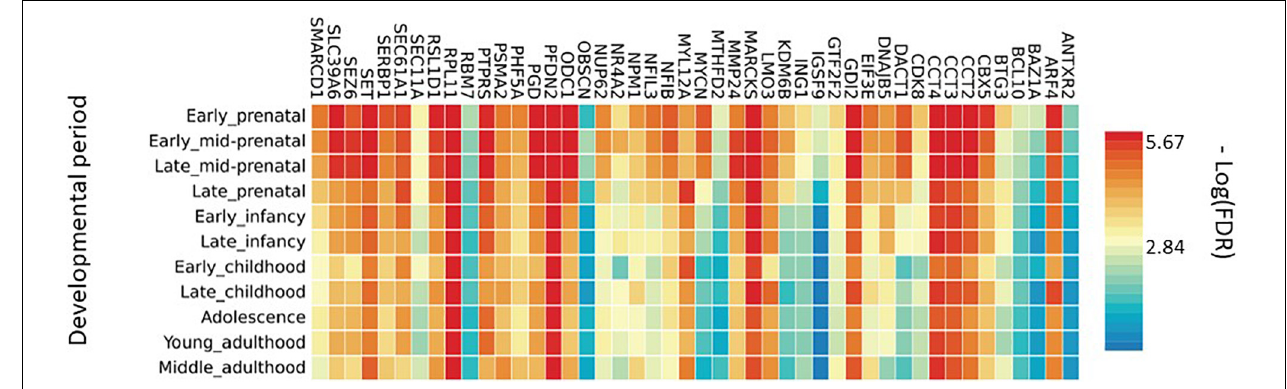
FIGURE 2 | Average gene expression in brain areas at different developmental